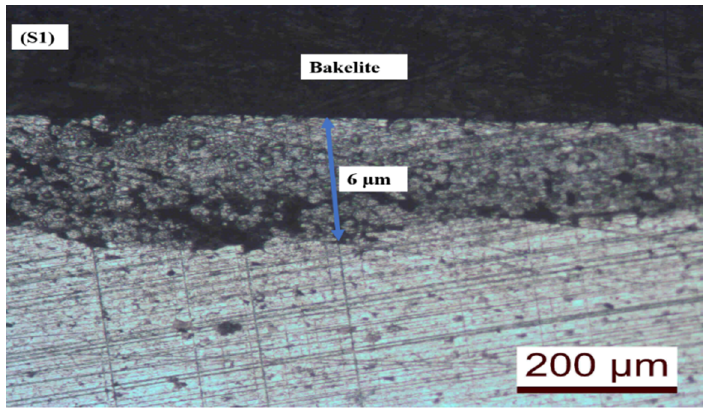
Figure 7. Surface nitride layer of sintered samples.